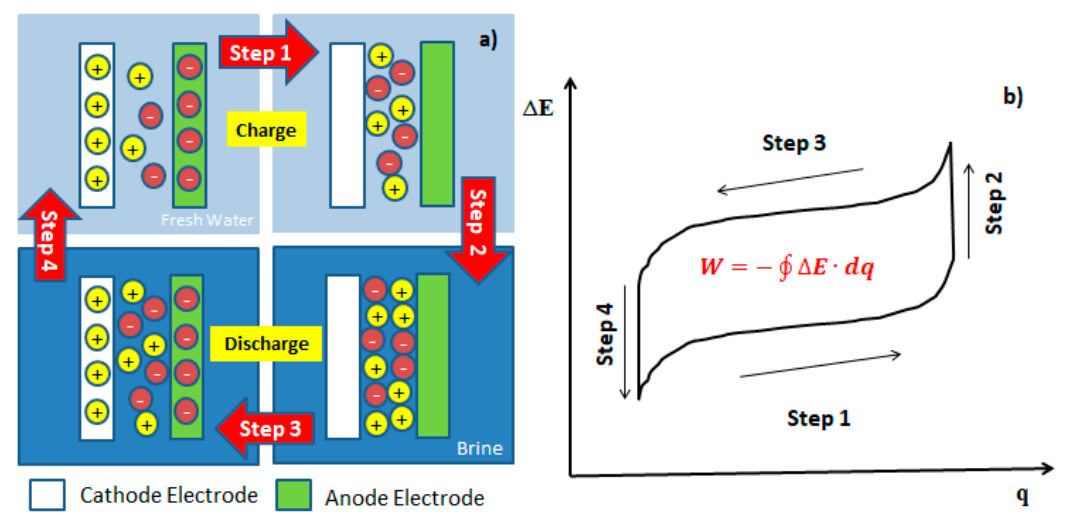
Figure 1. ( a ) Schematic representation of the systematic work of the mixing entropy battery (MEB). ( b ) Typical Brogioli cycle, where the battery cell voltage ( ∆ E ) vs charge ( q ) is represented. The closed integral represents the removable energy ( W ) of cycle.